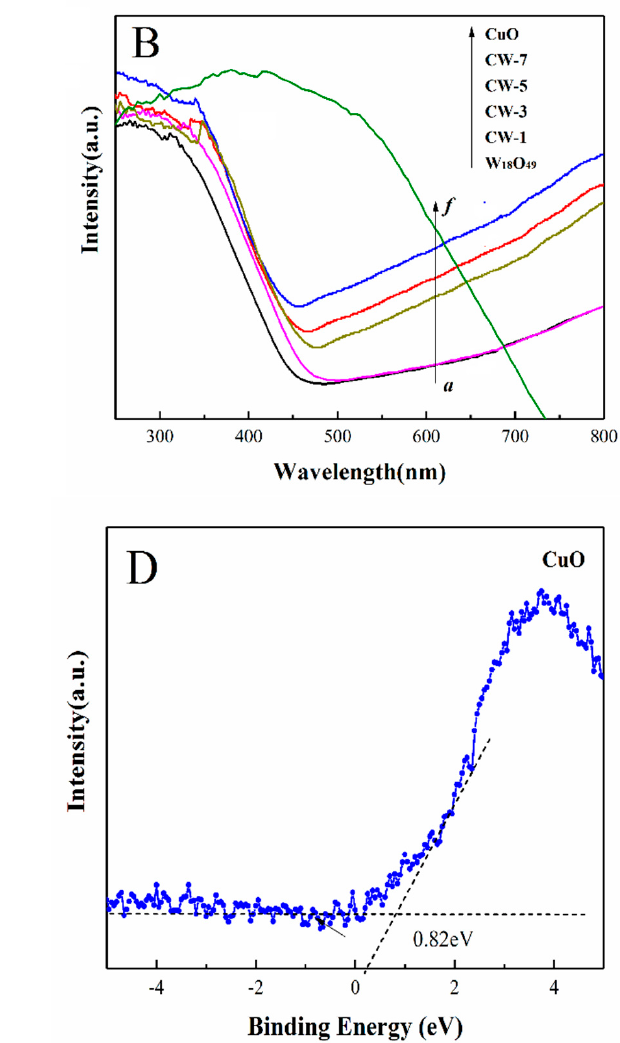
7 of 13 Figure 3. The survey spectra ( A ), W4f ( B ), O1s ( C ) and Cu2p ( D ) core-level spectrum of CW-5 sample. Electron paramagnetic resonance (EPR) spectroscopy, a high sensitivity method for unpaired spin detection, was employed to further investigate the difference of surface ox- ygen vacancies in our synthesized samples. As shown in Figure 4A, a rather weak oxygen vacancies signal appeared at g = 2.002 for W 18 O 49 samples, while, a stronger oxygen va- cancies signal can be observed in CW-5 sample, which indicated that more oxygen vacan-